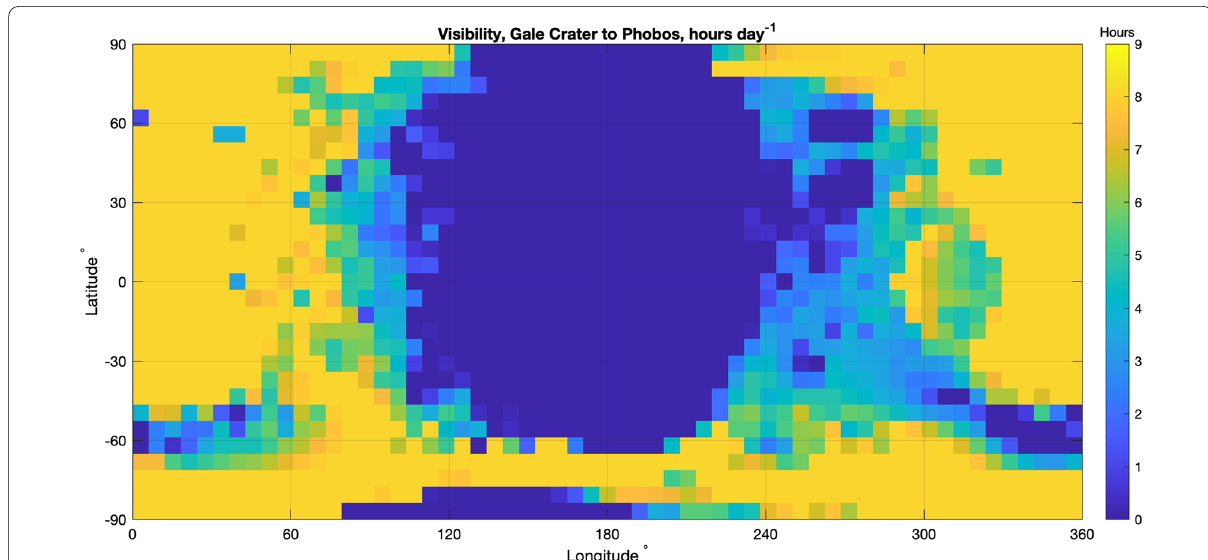
Fig. 6 Map of Phobos. Gale crater (Mars geographic coordinates, 5.4°S, 137.8°E) to Phobos visibility hours per day averaged over the period (1 Jan 2030 – 18 Nov 2031)